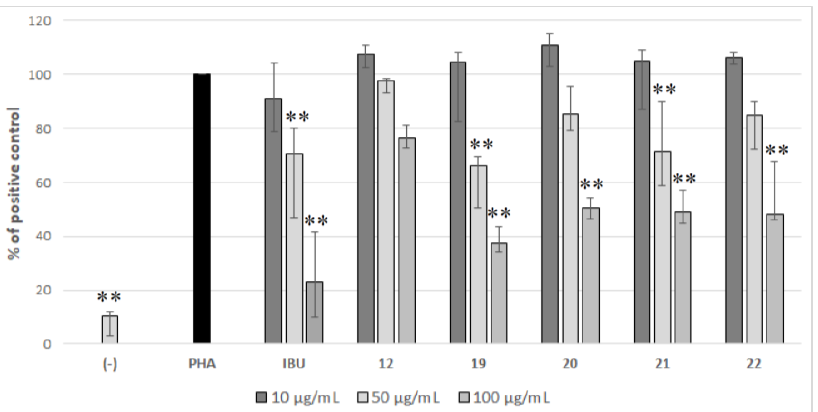
Figure 1. The effect of compounds 12 , 19 – 22 and IBU on the PHA-induced PBMC proliferation in 72 h cell cultures (the results are shown as percentage of positive control (PHA alone), with values expressed as medians from six independent experiments and interquartile ranges [Q1, Q3]); ** indicates a significant difference compared to positive control (PHA alone) at p < 0.01.